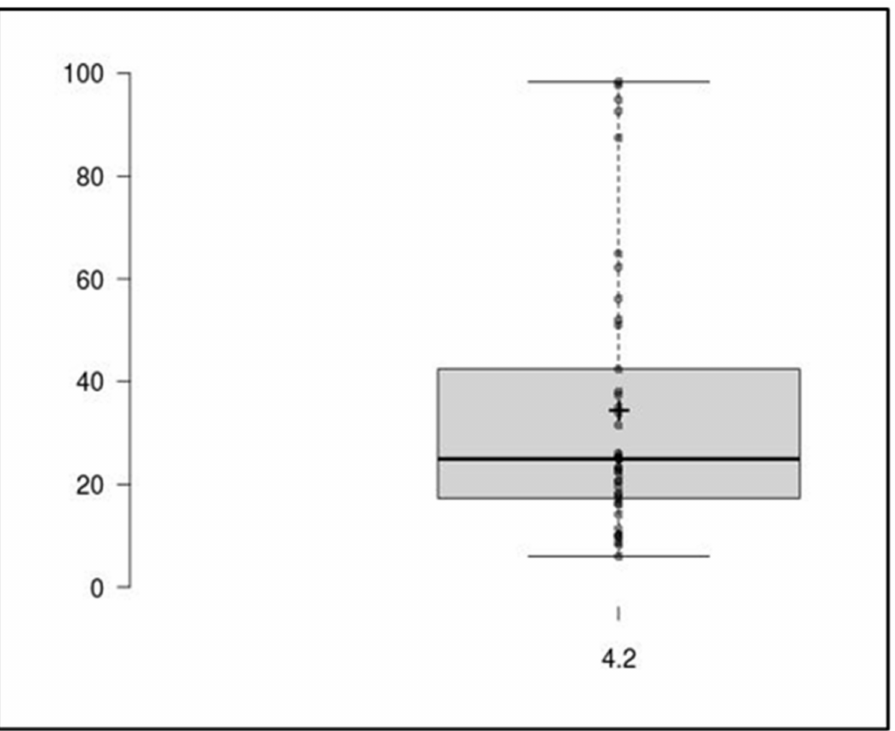
Figure 6. Box plot performed with the free online BoxPlotR tool, showing the spread of the VBR concentration measured in 42 real patients’ plasma microsamples. Population size: 42; Median: 24.95; Mean: 34.39; Minimum: 4.2; Maximum: 98.4; First quartile: 17.3; Third quartile: